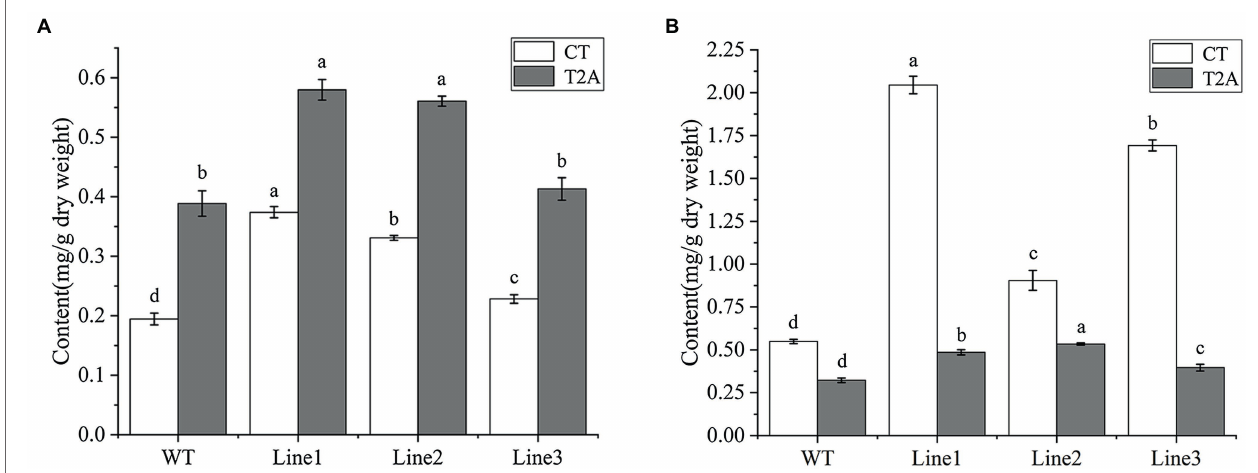
FIGURE 5 | UPLC analysis of cryptotanshinone and tanshinone IIA in transgenic root lines. (A) Transgenic regenerated plant root lines. (B) transgenic hairy root lines. WT, the root of wild-type plants; CT, cryptotanshinone; T2A, tanshinone IIA. Error bars represent means ± SD ( n = 3). Different letters indicate significant differences ( p < 0.05). The multiple comparison method used for the average level in this study was